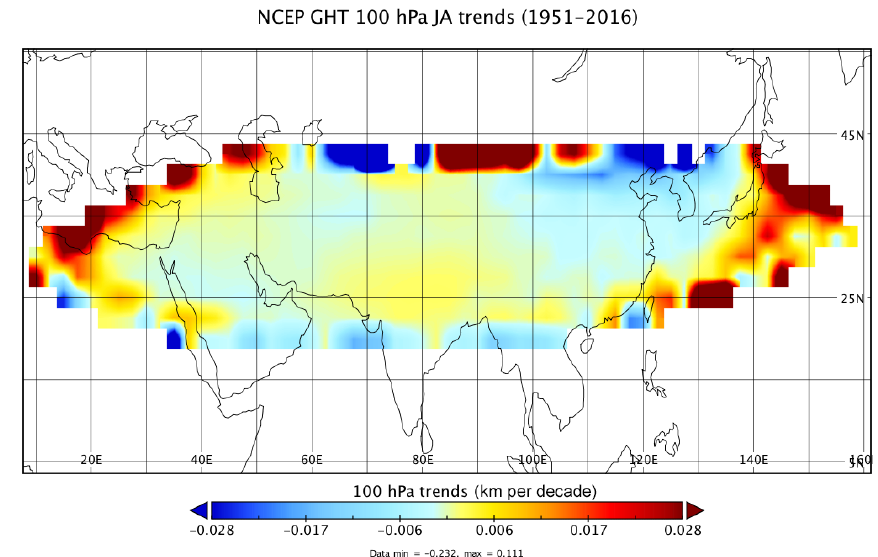
Figure 3. Spatial trend analysis obtained using robust regression analysis at a 95% confidence interval.